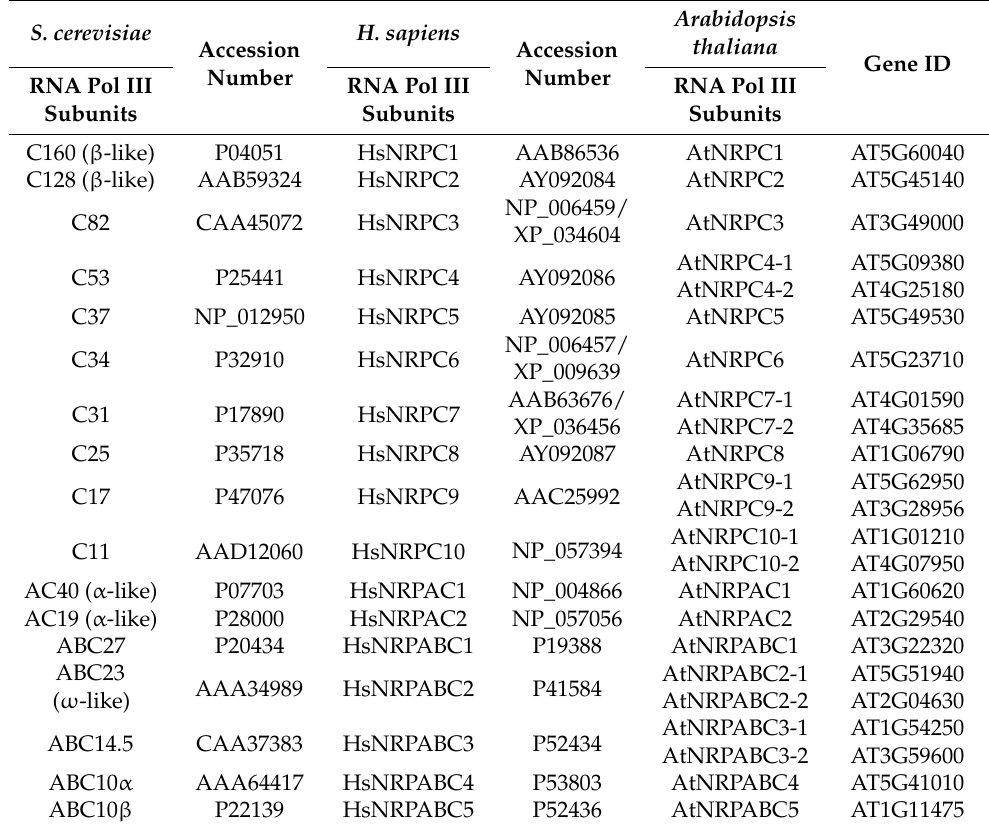
Table 1. The list of Arabidopsis RNAPIII subunits and their